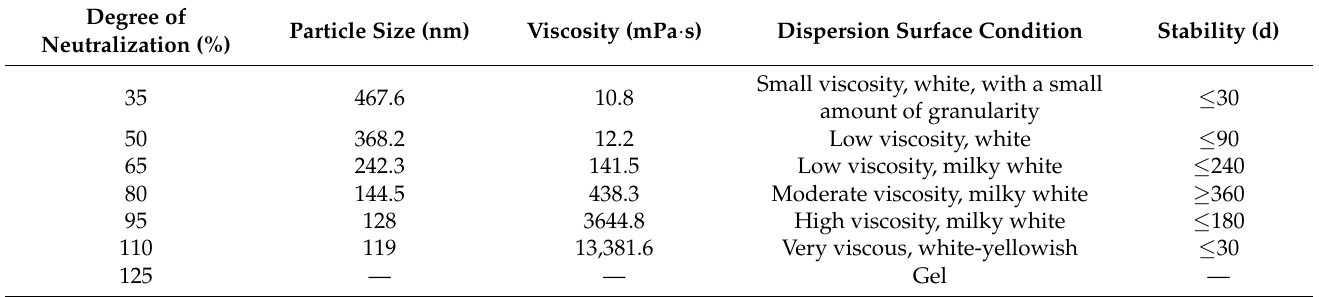
Figure 11. ( A ) Emulsion particle size distribution and ( B ) zeta potential distribution. Table 8. Comparison of the performance of emulsions with different degrees of neutralization.